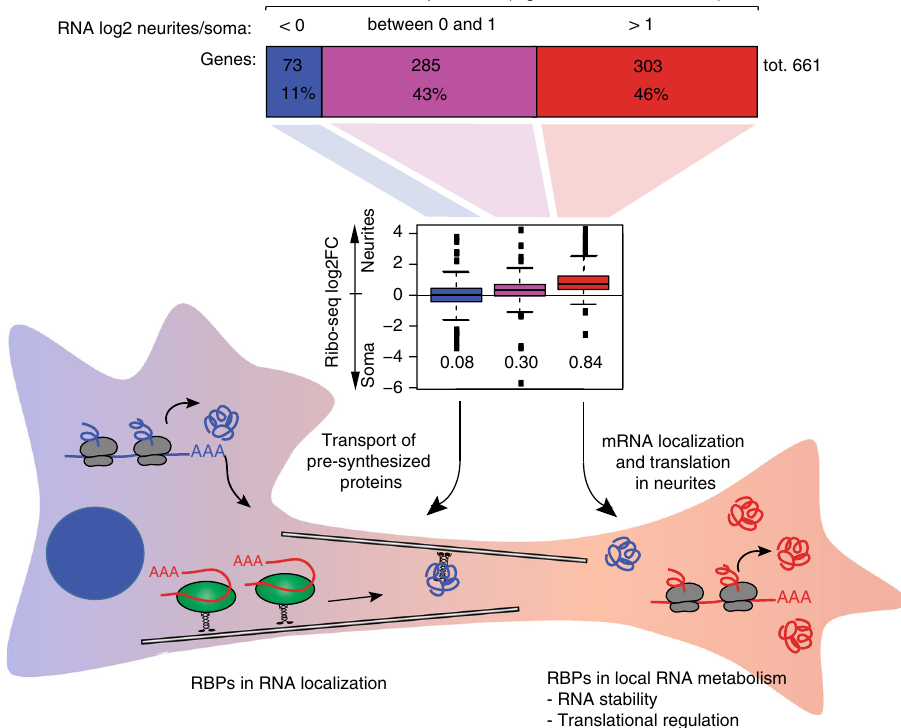
Fig. 7 RNA localization as the key determinant of protein localization and potential functional roles for RBPs. Scheme illustrating the contribution of mRNA localization to neurite-localized proteome. Neurite-localized proteins (proteomics log2 neurites/soma > 1, P -values < 0.05) were split into three groups based on encoding mRNA localization pattern ( upper panel ): proteins encoded by localized mRNAs (RNA-seq log2 neurites/soma > 1, P -values < 0.05), proteins encoded by moderately enriched mRNA (0 < RNA-seq log2 neurites/soma < 1), and proteins localized to neurites without a signi fi cant contribution of mRNA localization (RNA-seq log2 neurites/soma < 0). Boxplot ( middle panel ) shows mean Ribo-seq log2 neurites/soma values for these three gene categories. Neuron schematic representation ( lower panel ) illustrates the predominant mechanism of protein localization through local translation of neurite-localized